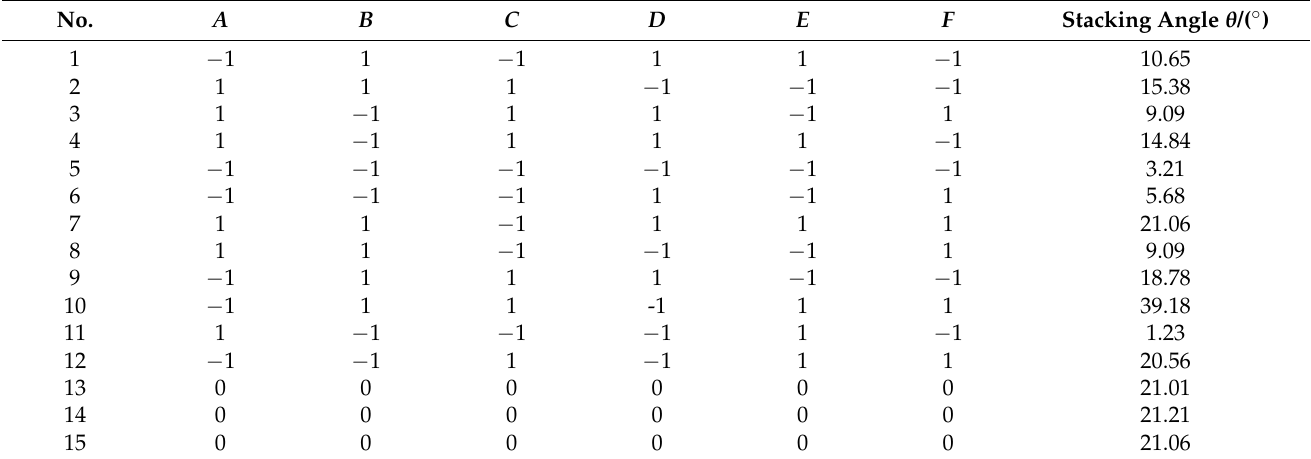
Table 3. Plackett–Burman test design and results.